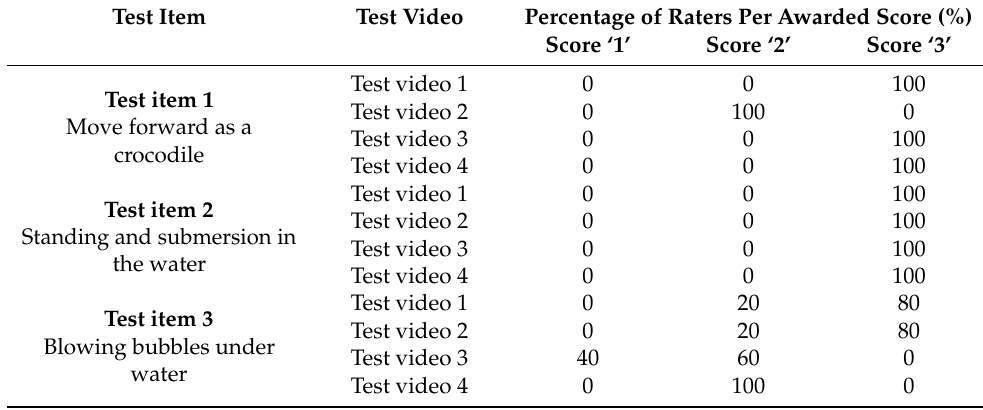
Table 5. Agreement table for inter-rater